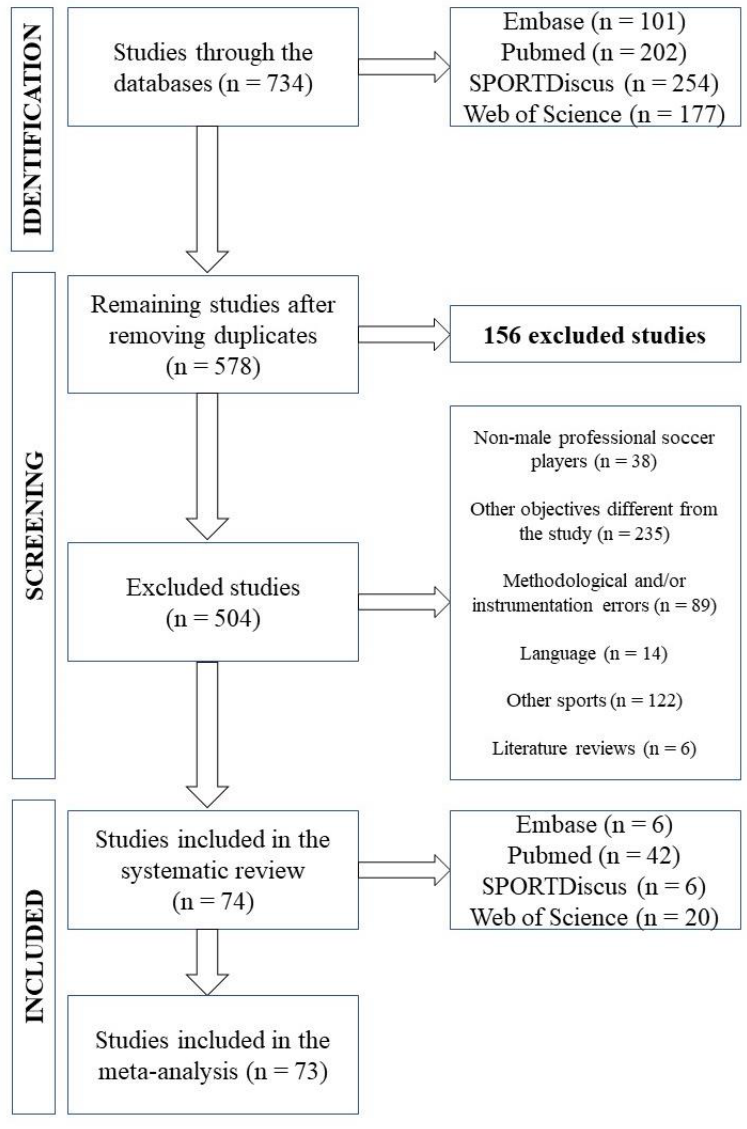
Figure 1. Flow diagram showing the process used to select the studies.